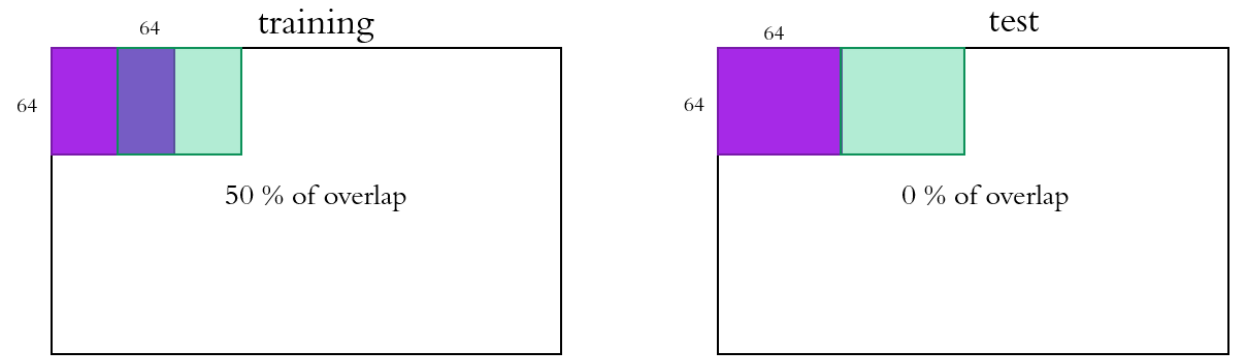
Figure 3. Schematic illustration of data augmentation created for training dataset for 64 × 64 pixel patches with 50% overlap. Image patches in the test dataset have an overlap of 0%.